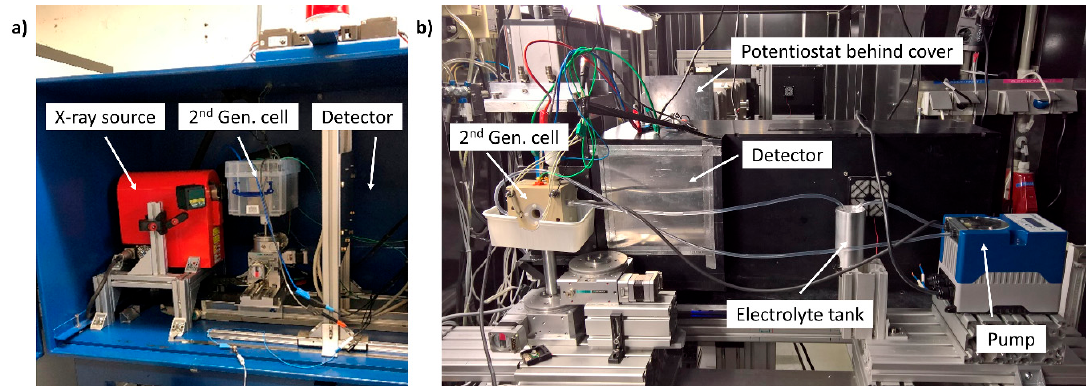
Figure 1. Photographs of the experimental in-operando set-up ( a ) micro-computed tomography at Helmholtz-Zentrum Berlin; ( b ) neutron radiography at CONRAD2 Berlin.